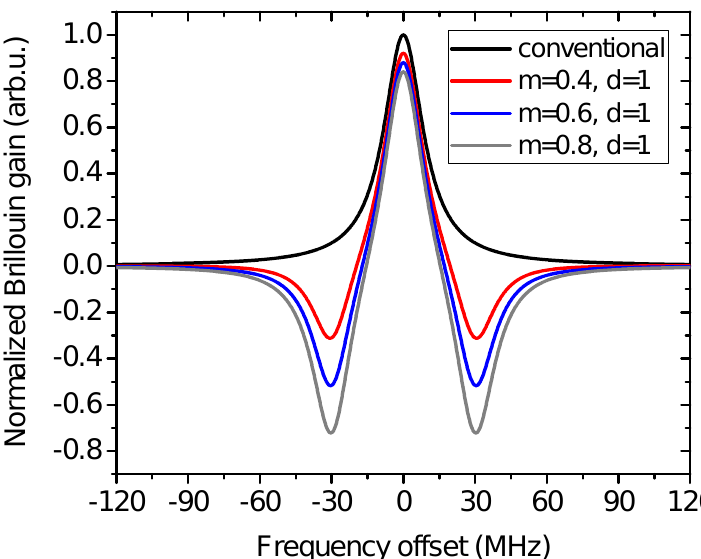
Figure 1. Engineered BGS by the superposition of a gain with two symmetric